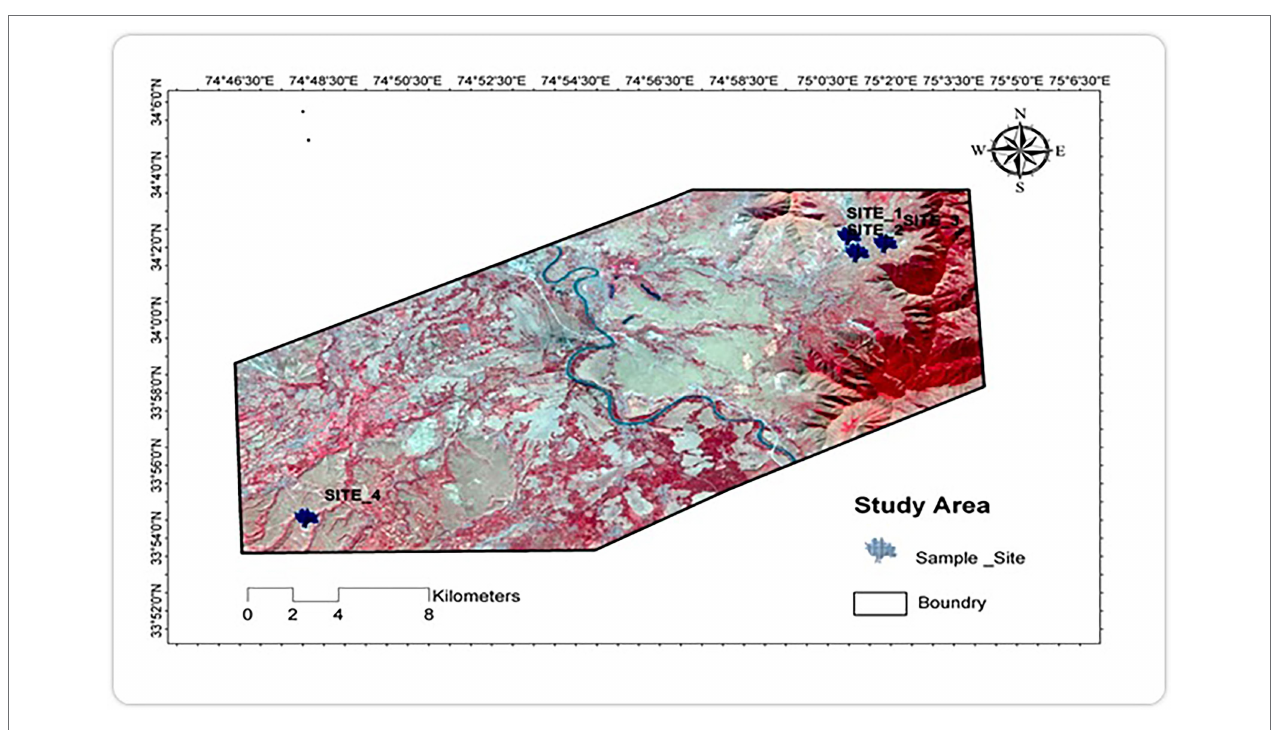
FIGURE 1 | Sampling area geographical